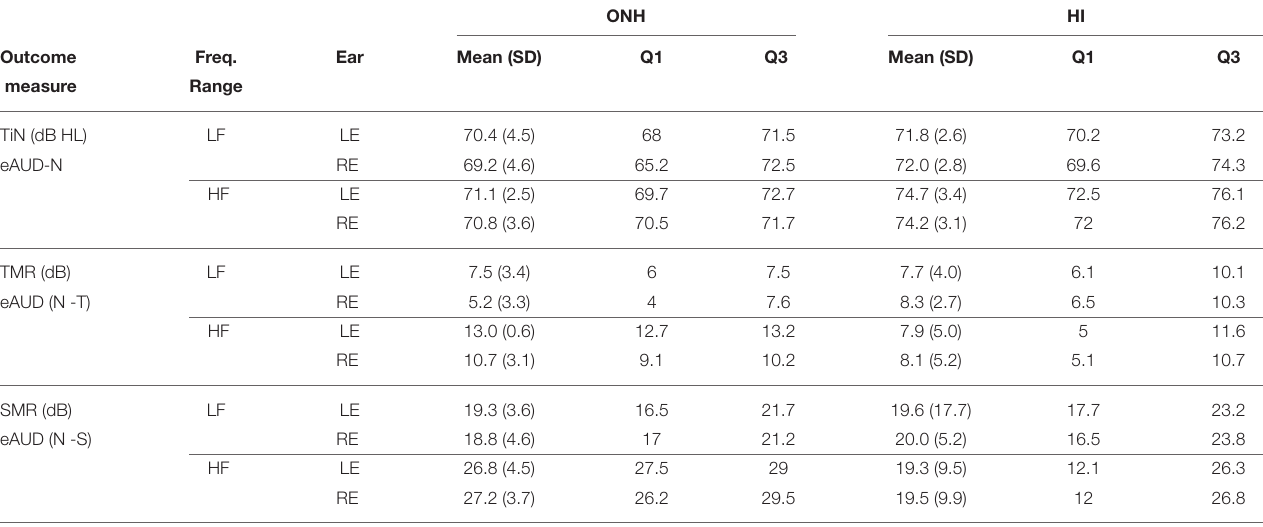
TABLE 9 | Summary of the results of the extended audiometry in noise (eAUD).